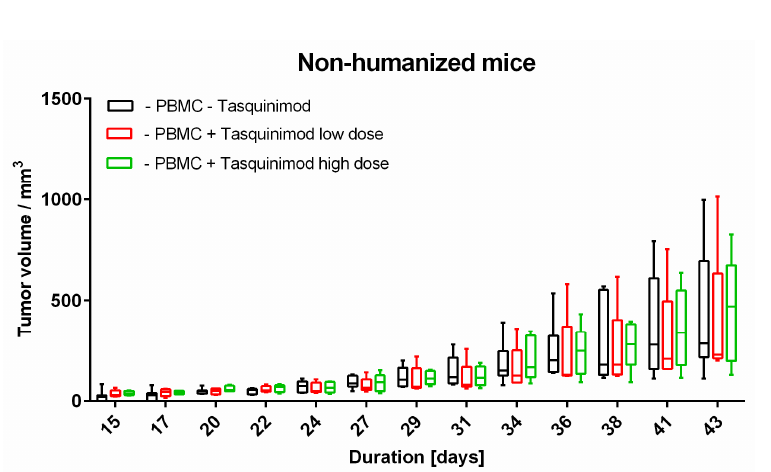
Figure A1. Tumor growth of Ma-Mel-19 cells in immunodeficient non-humanized mice under treatment with Tasquinimod. Tasquinimod was applied on day 24, 31, and 37. Data are shown as box plots with whiskers at min/max. seven animals in control group, five animals in both treated groups.